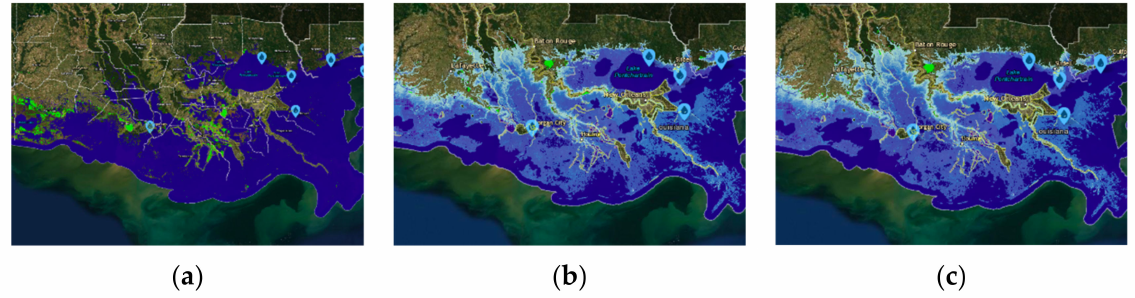
Figure 13. Here we show sea level ( a ) in 2021; ( b ) and predicted extreme flooding by 2050; ( c ) and 2100 in New Orleans, Louisiana and